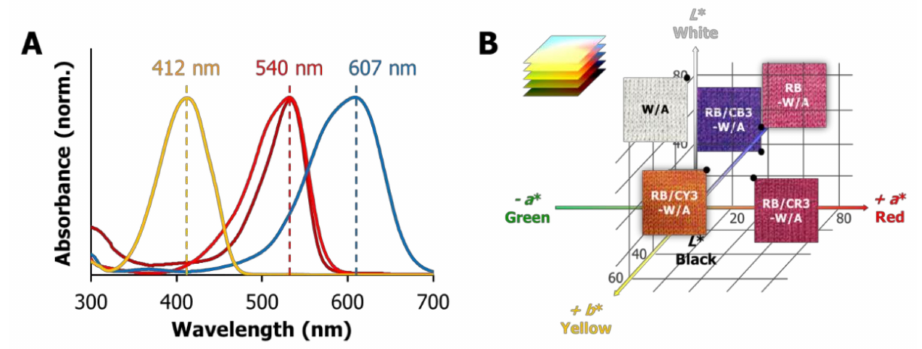
Figure 1. ( A ) Normalized UV-visible spectra of rose bengal (RB; maroon), cationic yellow X-8GL (CY; yellow), cationic blue X-GRL (CB; blue), and cationic red X-GTL (CR; red) in deionized water. ( B ) Photographic images of wool / acrylic (W / A), RB-W / A, RB / CY3-W / A, RB / CB3-W / A, and RB / CR3-W / A fabrics and their corresponding coordinate positions in CIELab color